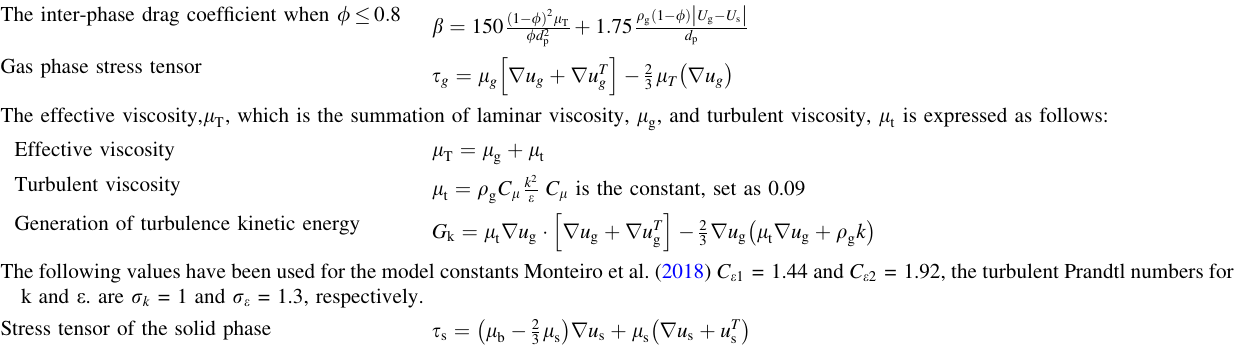
Radial distribution function of solid phase